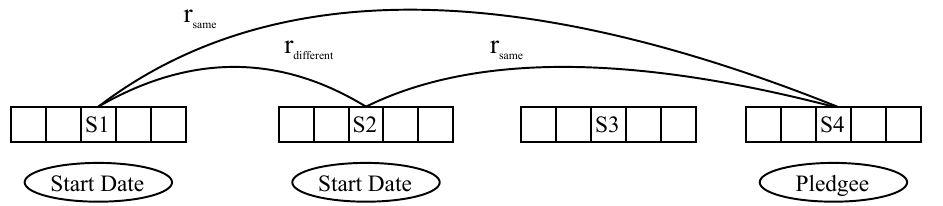
Figure 6. An example of relation-aware. Start Date and Pledgee can appear in an event like EO, but Start Date in S1 and Start Date in S2 can not appear in an